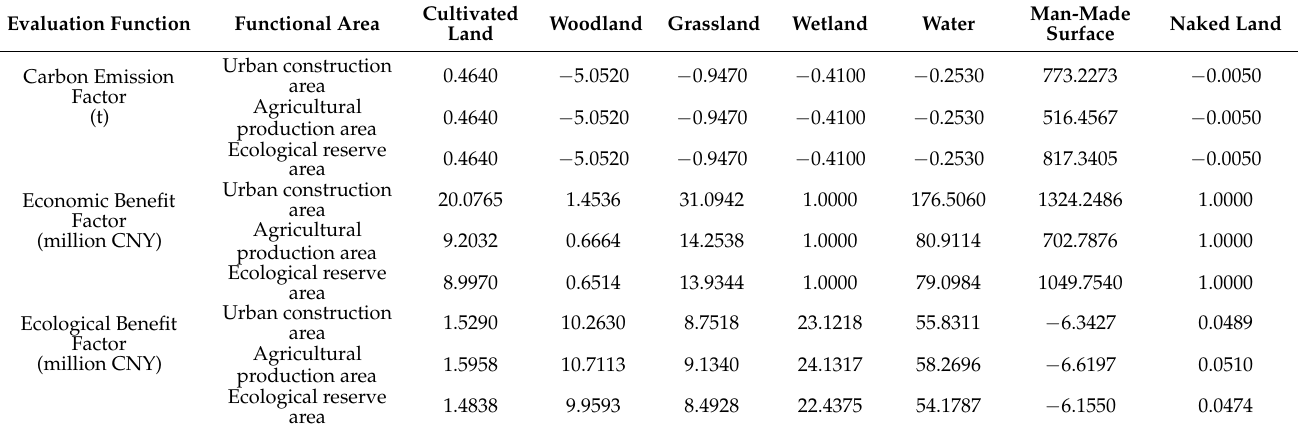
Table 5. Evaluation function coefficients of each district after revision in 2030.